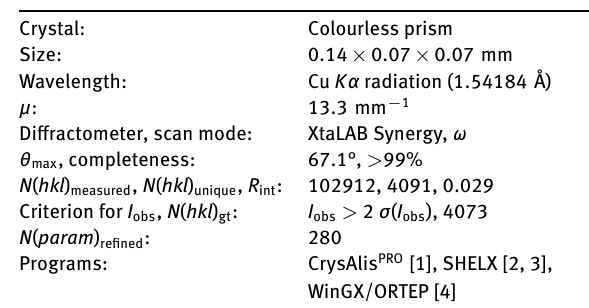
Table 1: Data collection and